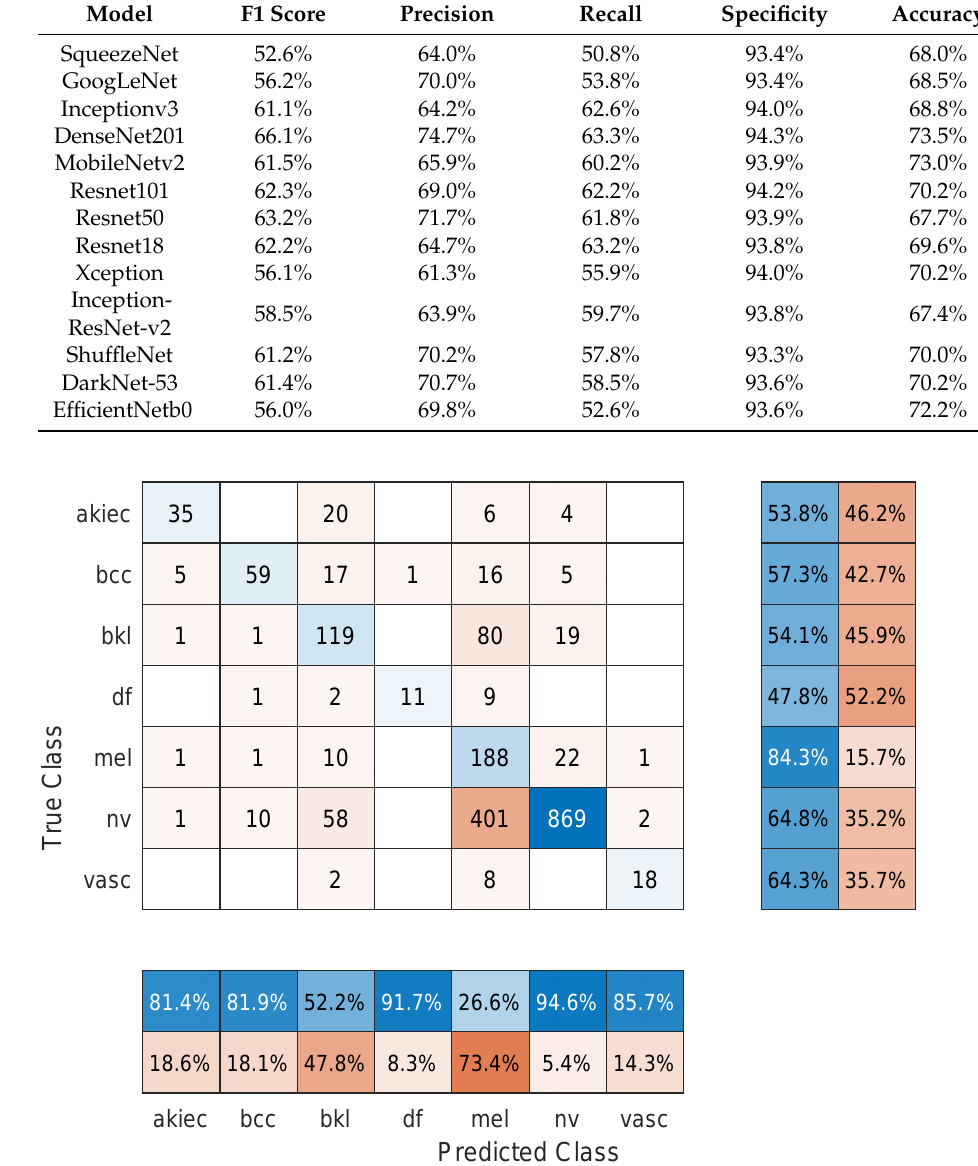
Figure 4. Sample confusion matrix for DenseNet201 model and 80/20 data